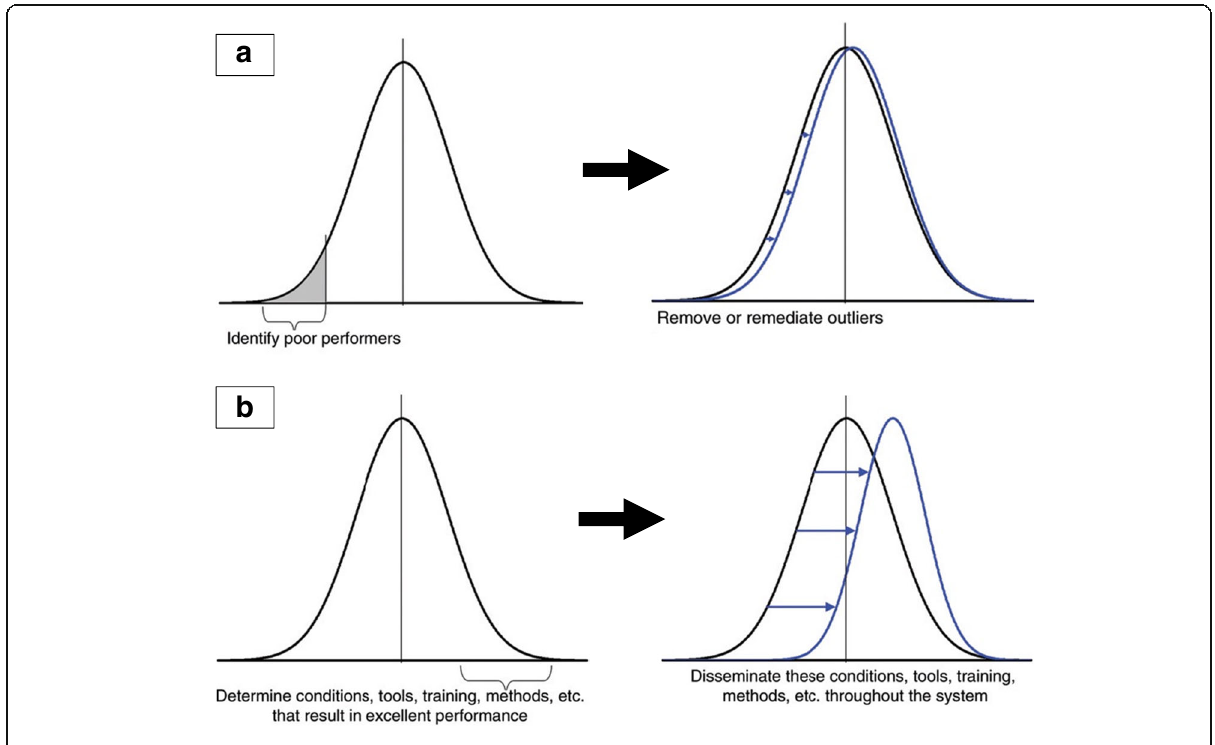
Fig. 4 The Larson theory described that addressing poor performance ( a ) has less effect on overall results in comparison to emulating excellent performance ( b )